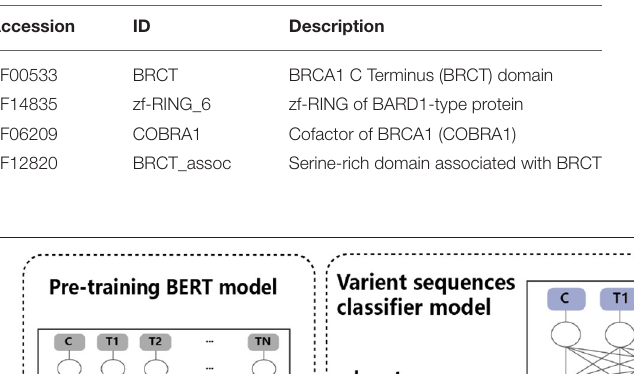
TABLE 1 | The statistics of BRCA1-related domain data from Pfam.